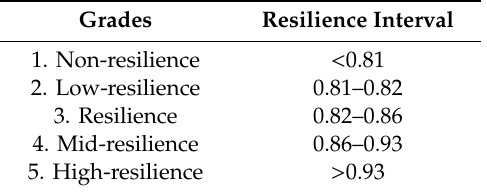
Table 5. Cluster range and resilience level of resilience